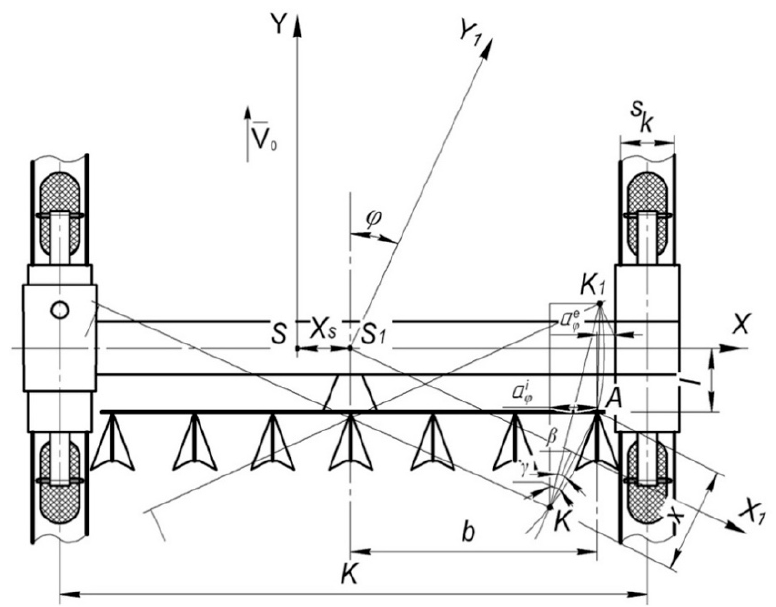
Figure 1. Transverse displacements of the wide span tractor and its working implements (coulters).